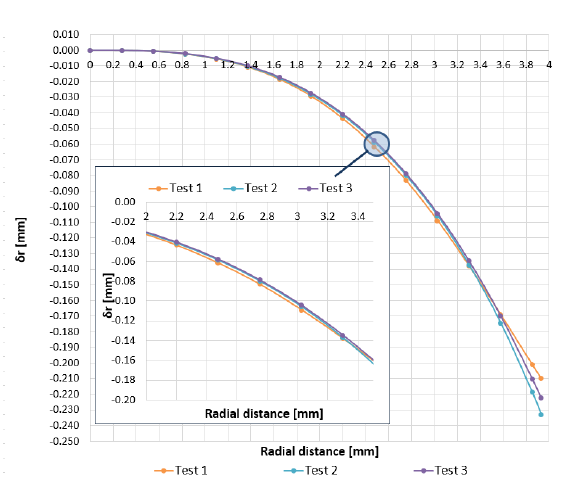
Figure 10 Radial Distortion Curves- T3